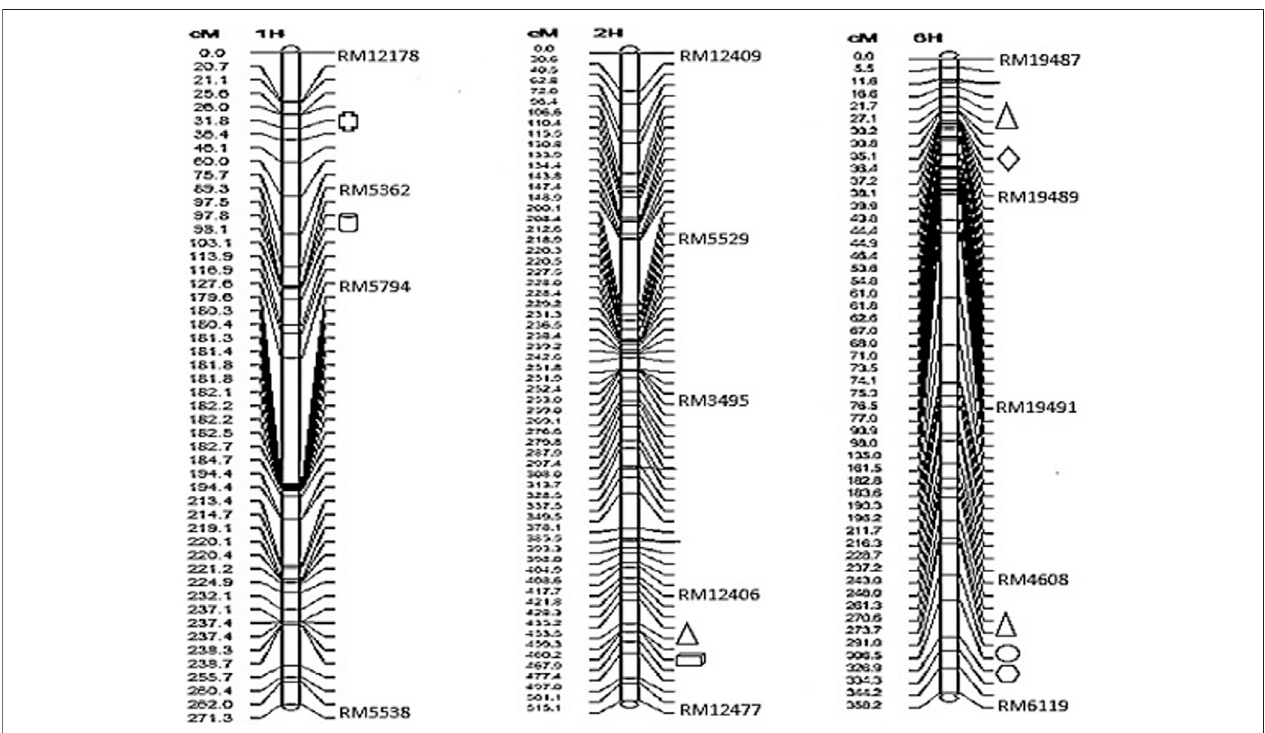
FIGURE 3 | The location and congregation of QTL affecting mineral elements content in NILs of Towada brown rice. QTL for Fe ( ), P ( ), Ca ( ), Zn ( ), Cr ( ), Mg ( ), and Sr ( ) are graphically highlighted for chromosome number 1 (from left), 2 and